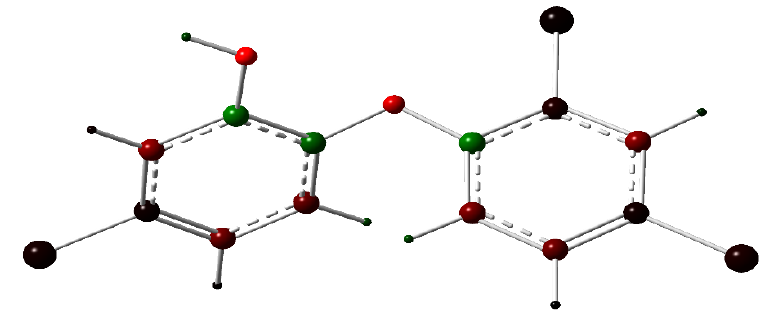
Fig 4. NBO contribution of triclosan electron by B3LYP/6-311++G(2d,2p)